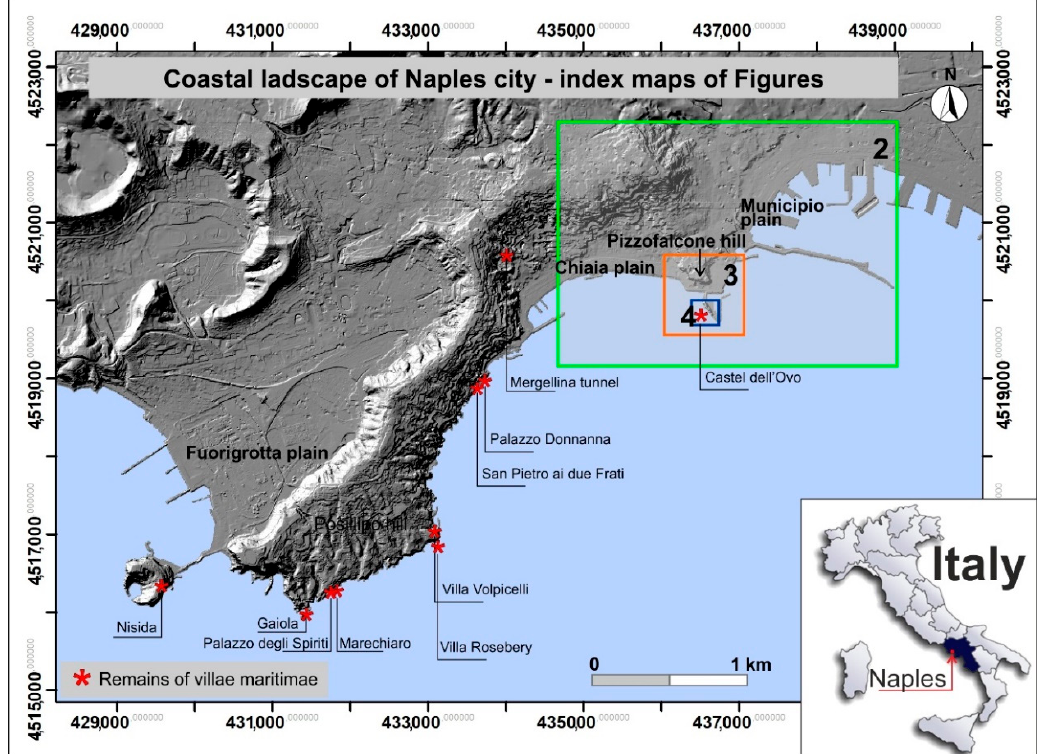
Figure 1. Location map of the villae marittimae described in Section 3 and index maps of the Figures contained in this text: (2) extent of Figure 2; (3) extent of Figures 3 and 6; (4) extent of Figures 7, 8, 10 and 11. The shaded relief was obtained from the digital terrain model (DTM), calculated by interpolating the 2013 LIDAR data provided by the Ministry of Environment.